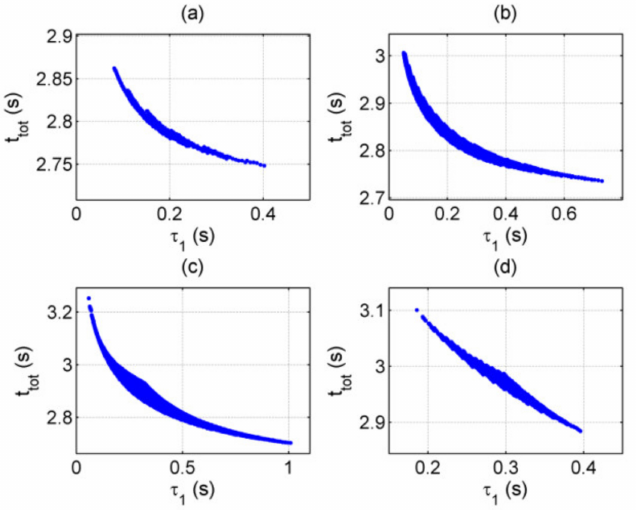
Figure 19. The relationship between the total charging time and time constant τ 1 for the four battery pack structures in the Enumeration algorithm’s feasible solutions, respectively. ( a ) N = 35. ( b ) N = 25. ( c ) N = 14. ( d ) N =